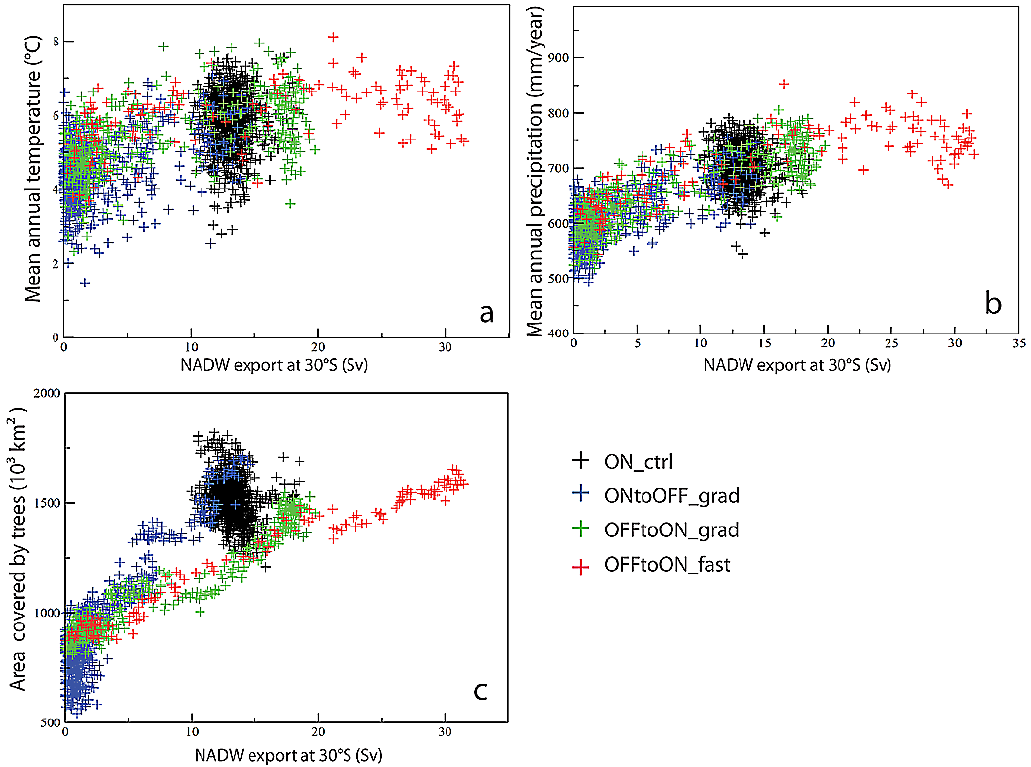
Fig. 15. (a) Mean annual temperature ( ◦ C), (b) mean annual precipitation (mmyr − 1 ) and (c) area covered by trees (10 3 km 2 ) over Western Europe (lat=32/60 ◦ , lon= − 15/20 ◦ ) vs NADW strength at 30 ◦ S (Sv) for simulations ON ctrl (black), ONtoOFF grad (blue), OFFtoON grad (green) and OFFtoON fast (red). Each cross corresponds to the result for one